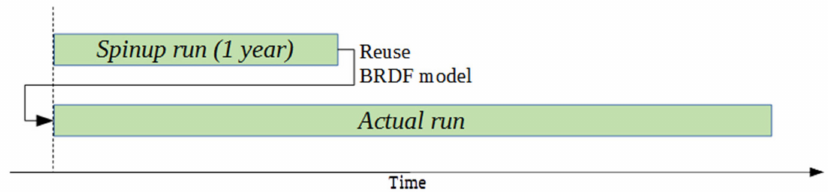
Figure 4. Spin up and actual